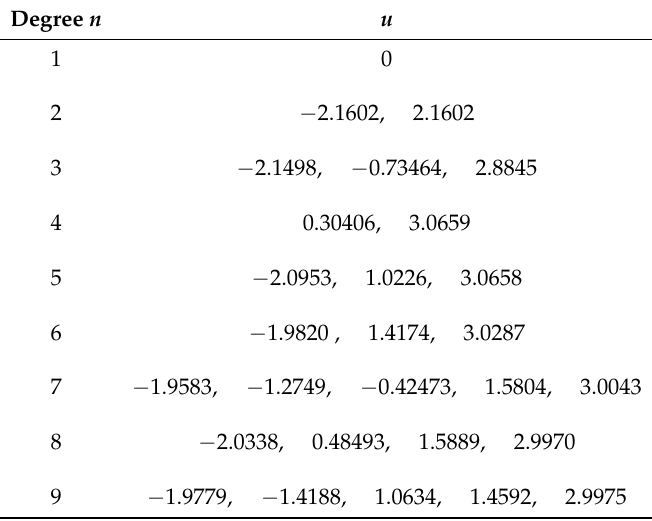
( m ) ( u , v ) = 0 for u ∈ R n , q